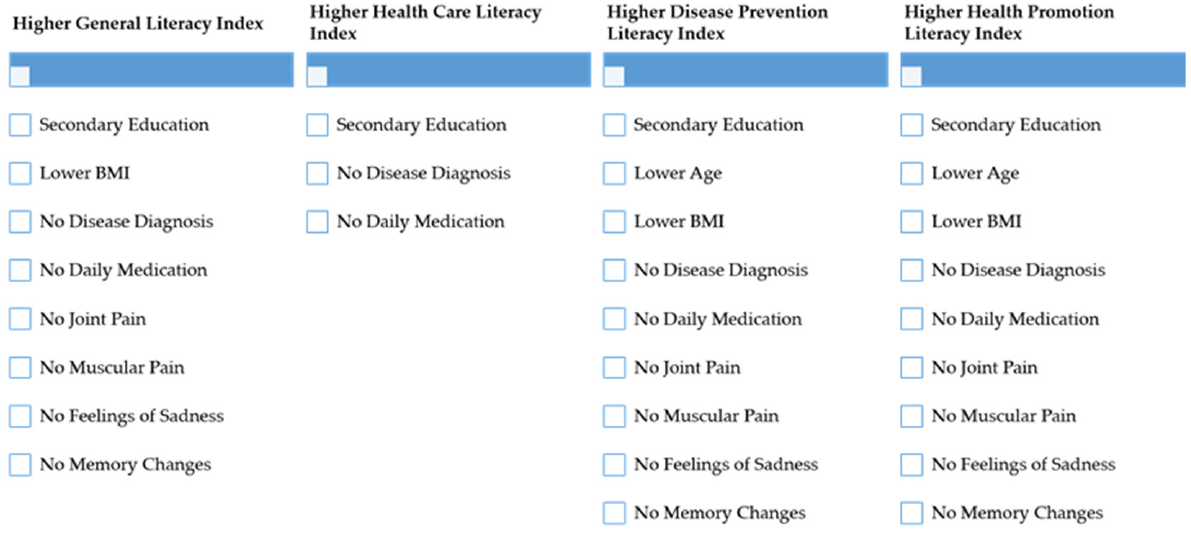
Figure 1. Variables associated with higher levels of health literacy. Source: Authors. BMI—body mass index.